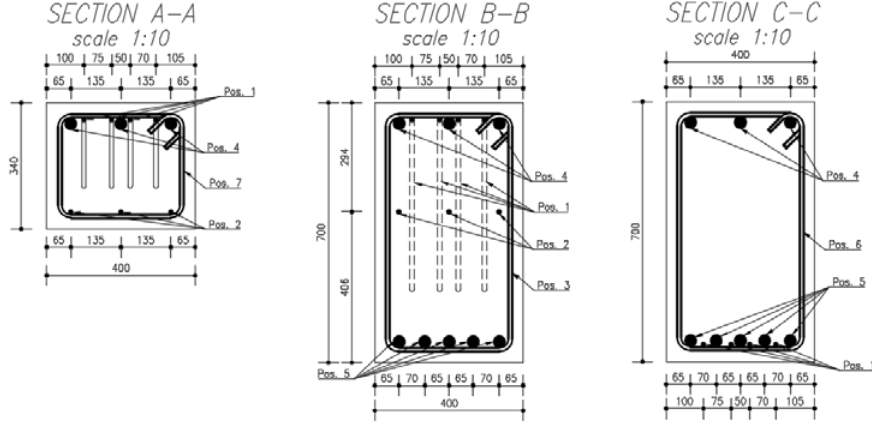
Figure 6. Cross sections A–A, B–B, and C–C.